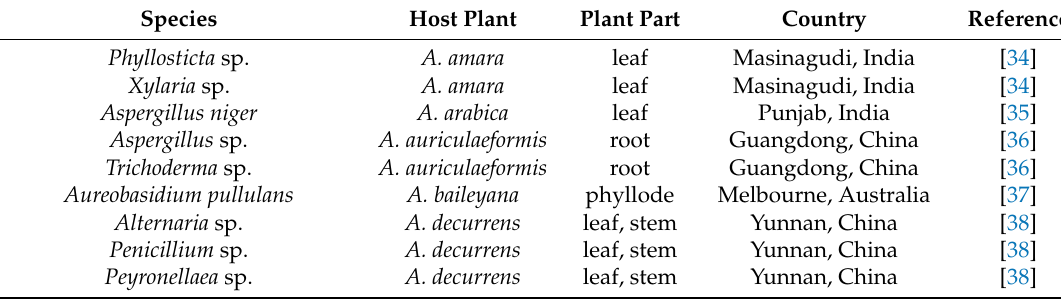
Table 2. Endophytic fungi isolated from Acacia